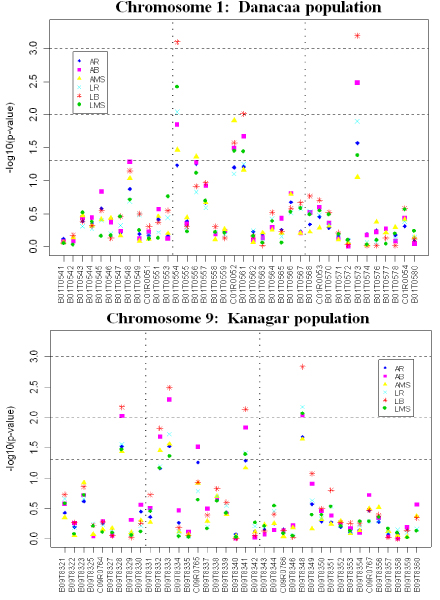
Results of chi-square test to detect differences in allele frequency between cases and controls using six case-selection strategies. The six case-selection strategies are: i) a randomly selected case (AR); ii) a case showing most IBD sharing with other affected sibs (AB); iii) a case with the most severe disease (AMS); iv) a randomly selected case per linked family (LR); v) a case with most IBD sharing with other affected sibs from linked families only (LB); vi) a case with the most-severe disease chosen from linked families only (LMS). The horizontal dashed lines on both figures denote p-values of 0.05, 0.01, and 0.001, respectively. The regions between the vertical dashed lines represent the haplotype region containing the disease locus.